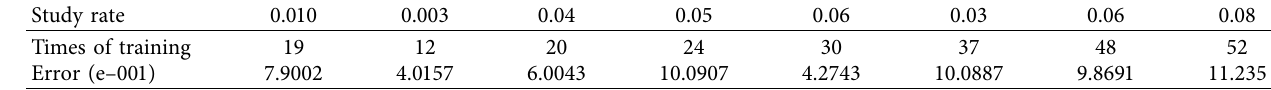
Table 5: Comparison results of different learning